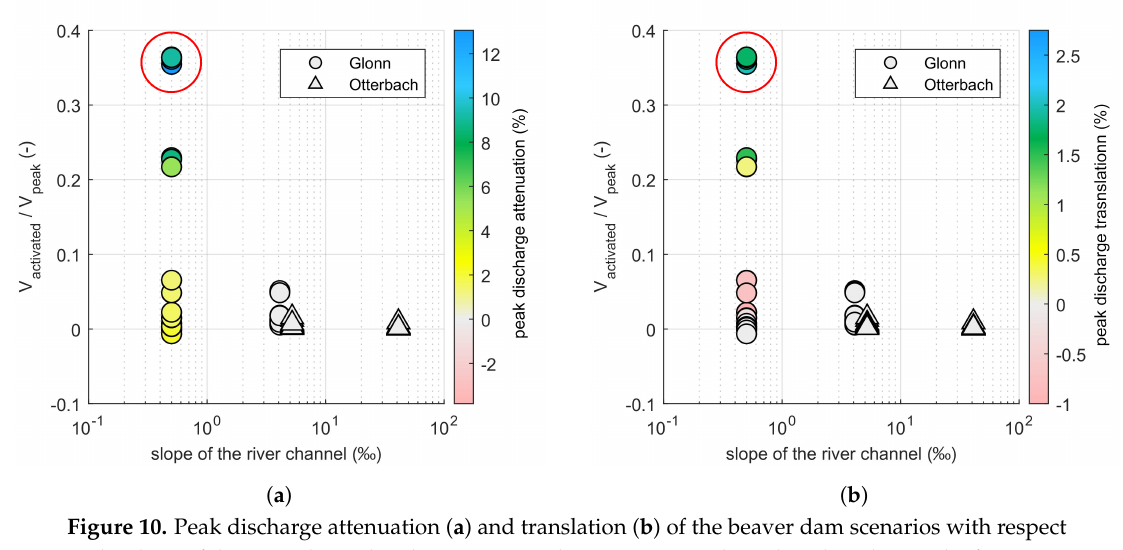
Figure 10. Peak discharge attenuation ( a ) and translation ( b ) of the beaver dam scenarios with respect to the slope of the river channel and V activated in relation to V peak . The red circle indicates the four most effective scenarios in both